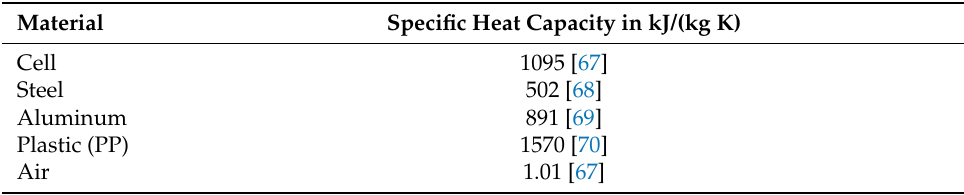
Table 4. Literature values for specific heat capacity.